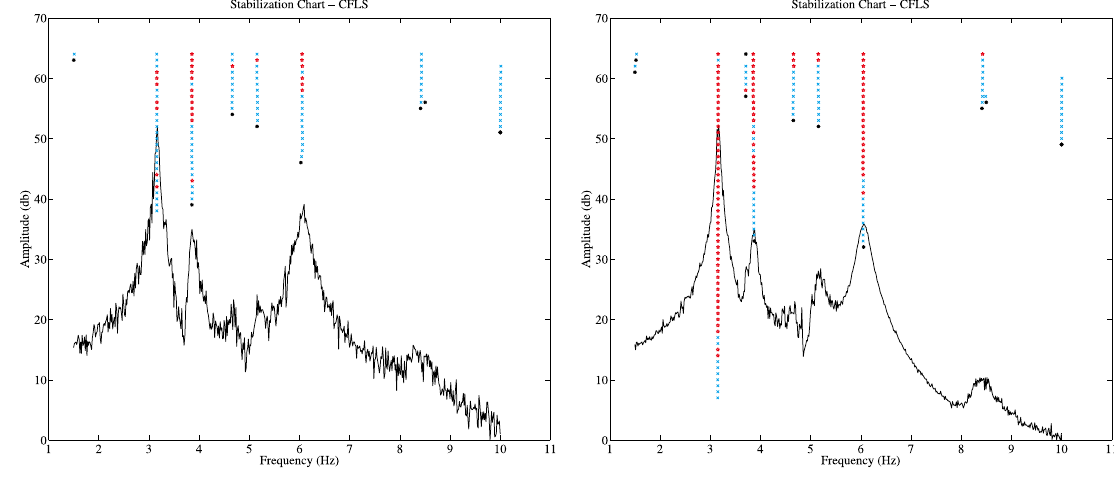
Fig. 7. Stabilization diagrams based on (left) Power Spectra OMAX (right) Transmissibility OMAX.